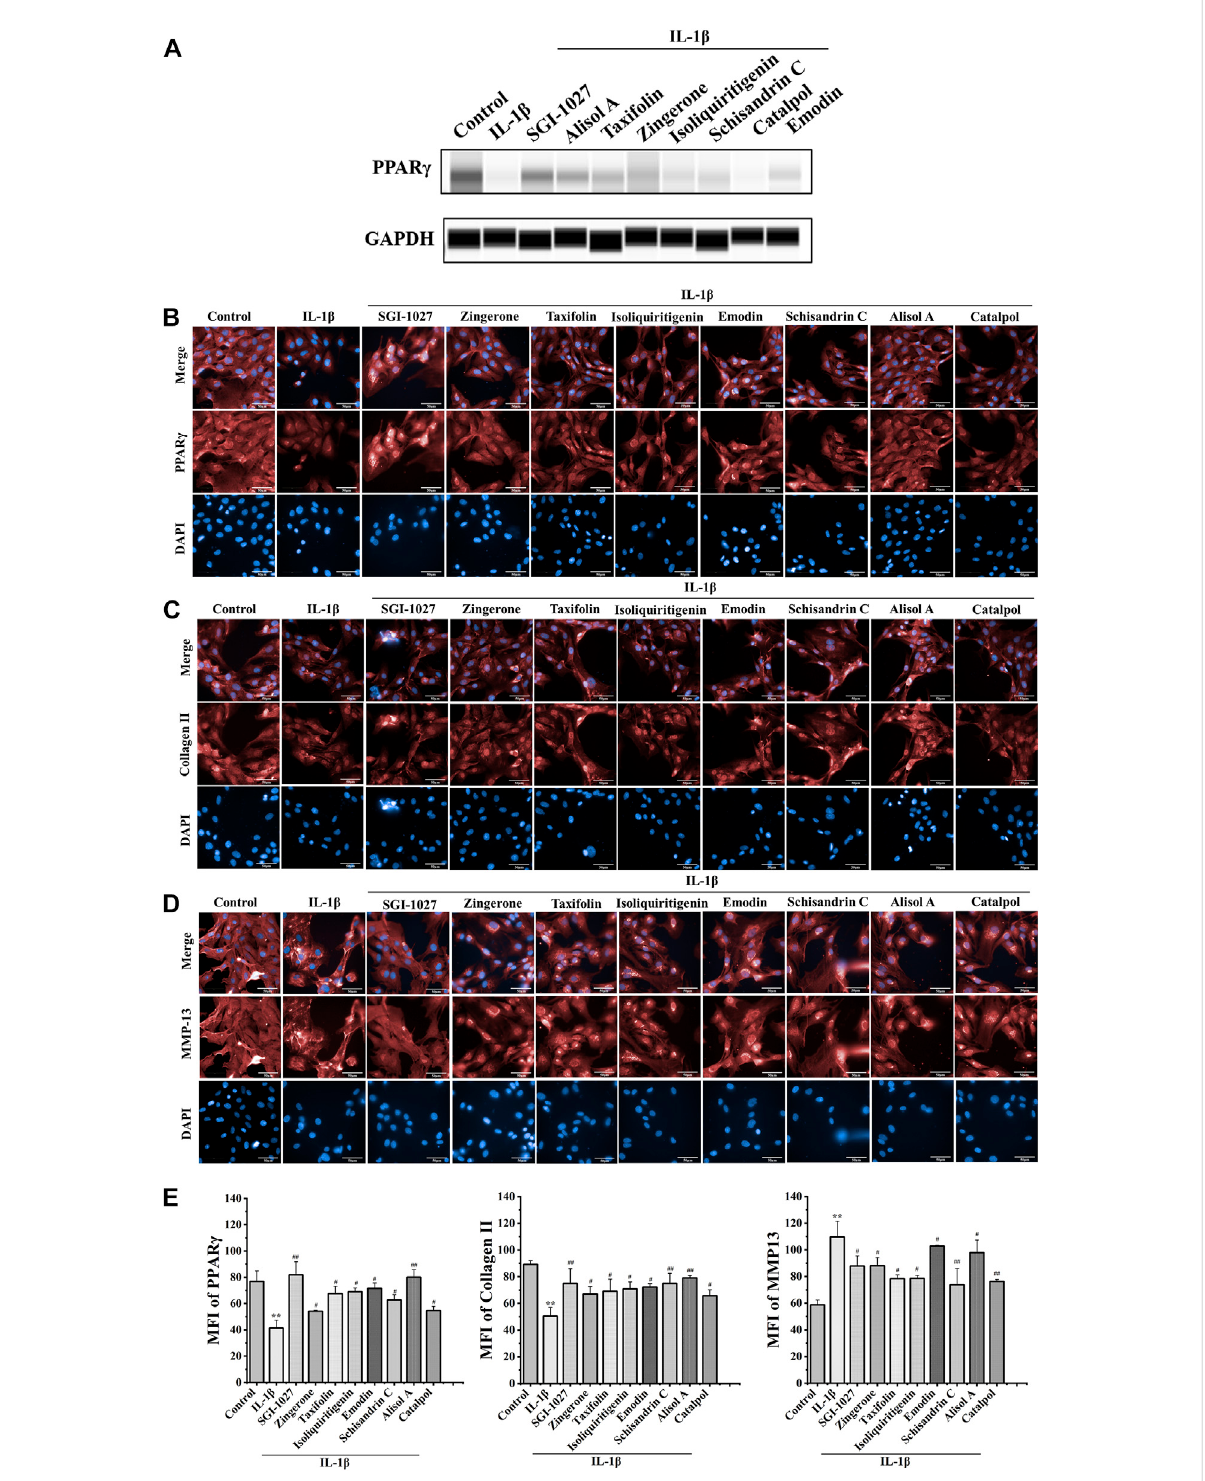
FIGURE 4 Effect of seven potential active constituents (Isoliquiritigenin, Emodin, Taxifolin, Catalpol, Alisol A, Zingerone, and Schisandrin C) on PPAR γ , collagen II, and MMP-13 in IL-1 β -treated chondrocytes. (A) The expression of PPAR γ in IL-1 β -treated chondrocytes by protein capillary electrophoresis; (B) PPAR γ (red)wasdetectedbyimmuno fl uorescence; (C) CollagenII(red)wasdetectedbyimmuno fl uorescence; (D) MMP-13(red) was detected by immuno fl uorescence; (E) Quanti fi cation analysis of the immuno fl uorescence of PPAR γ , collagen II, and MMP-13. ** p < 0.01 compared with the control group; # p < 0.05, ## p < 0.01 compared with the IL-1 β